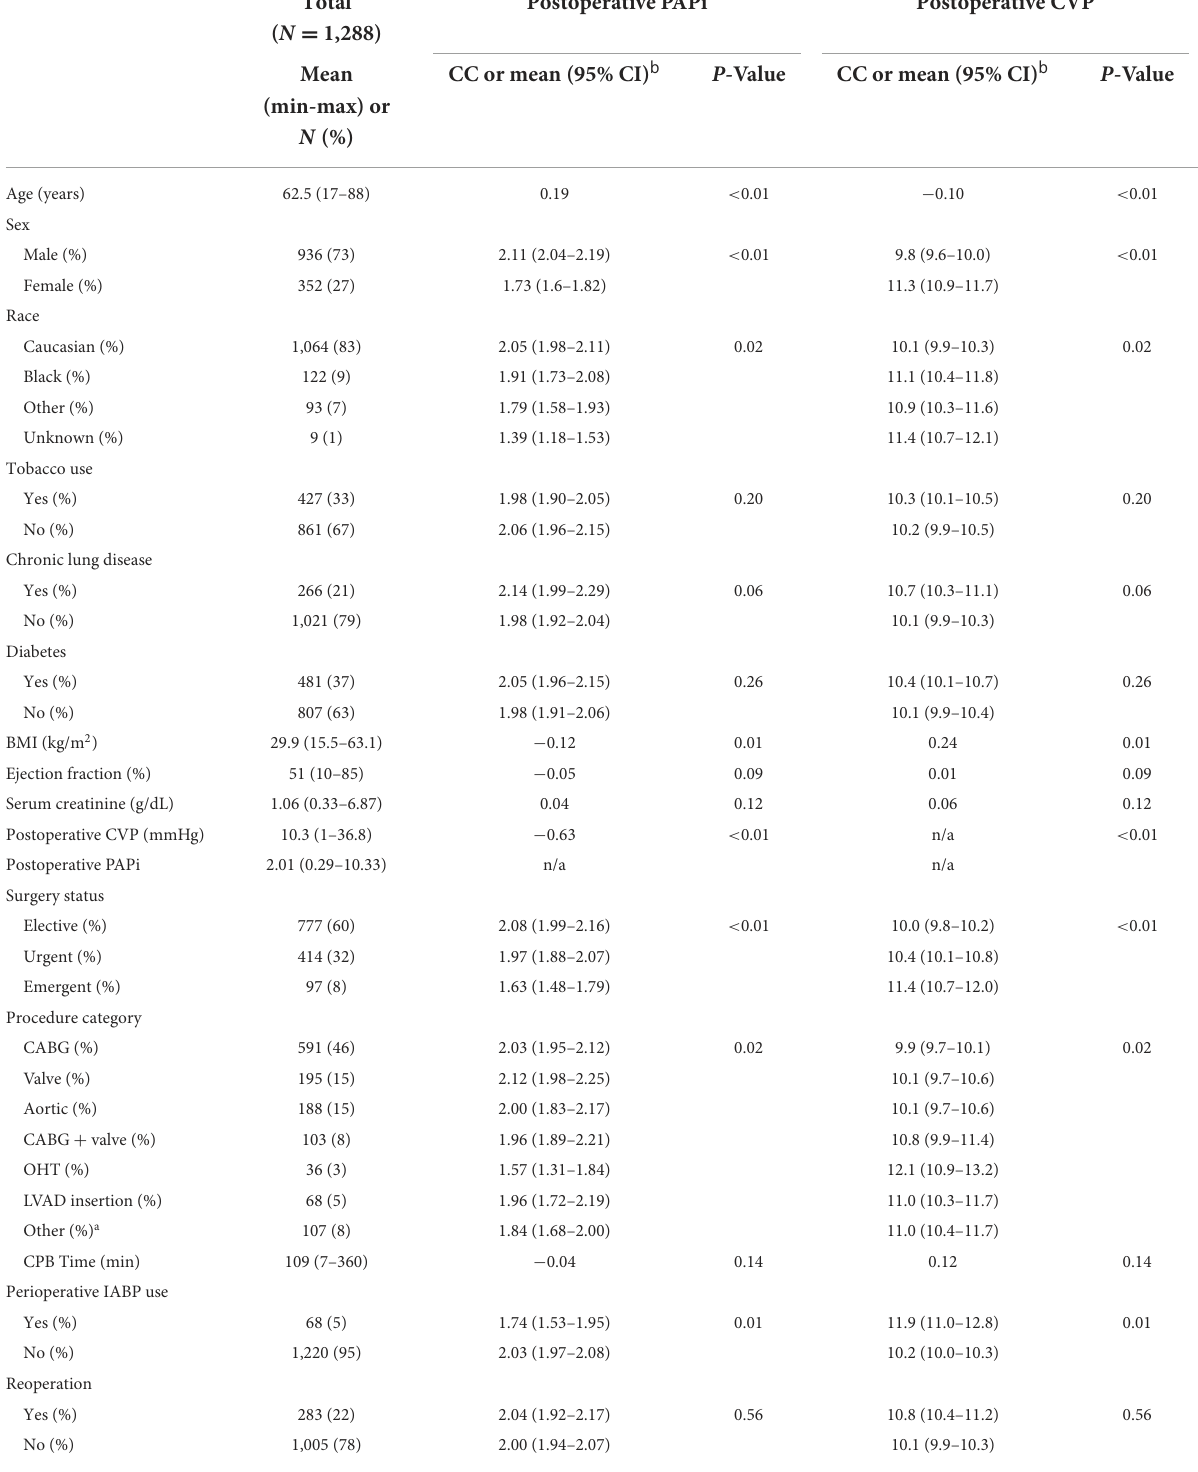
TABLE 1 Patient characteristics and their association with postoperative PAPi and CVP